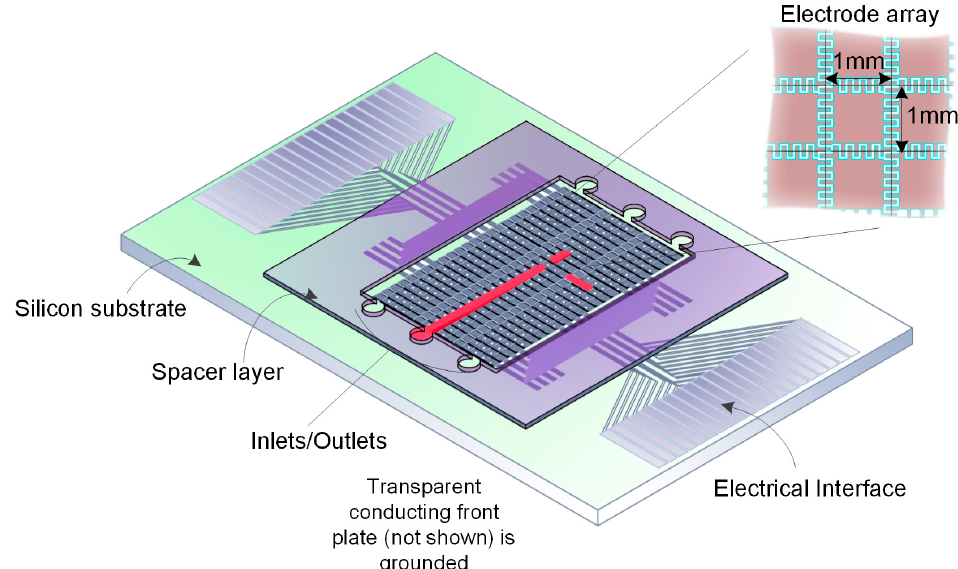
Figure 1. Microfluidic platform based on electrowetting, integrating continuous and digital paradigms. The inset shows arrayed electrodes of size of 1 mm 2 . The sample in introduced through the inlet in the form of a channel, and droplets are split from the channel. The transparent conducting front plate (not shown) is